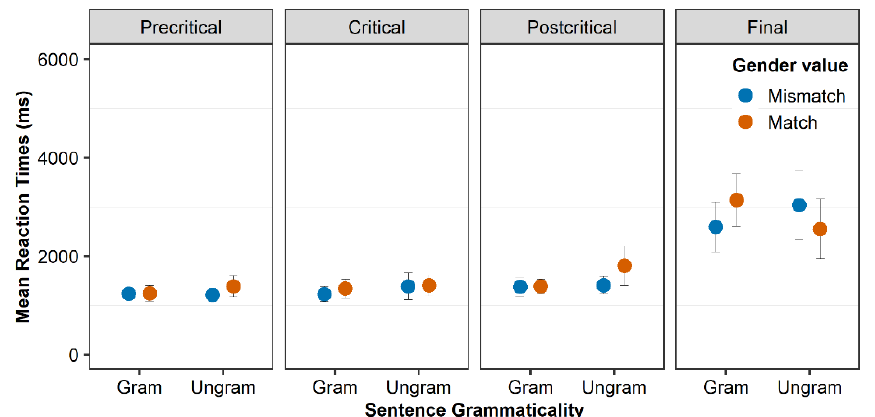
Figure 4. RTs of the L1 group per segment.